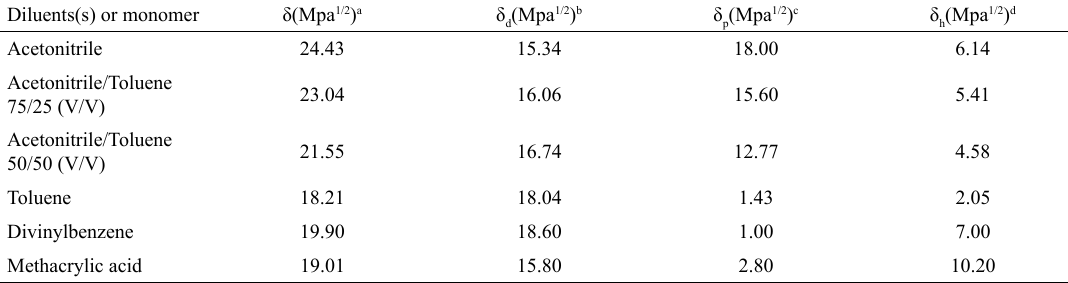
Table 2. Hansen/Hildebrand solubility parameters of the diluents and monomers13 Diluents(s) or monomer